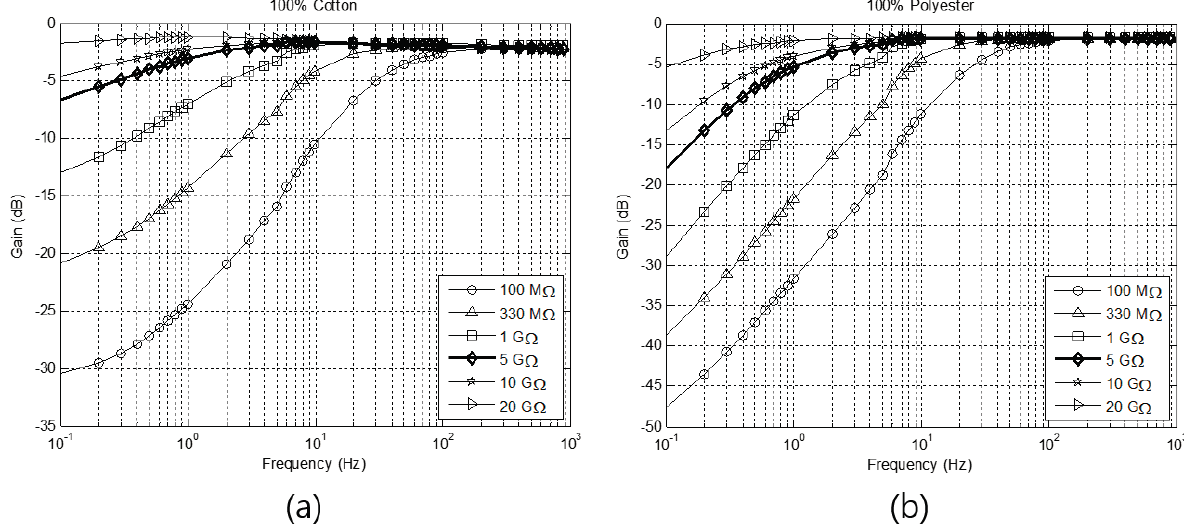
Figure 4. Frequency responses for different resistances: ( a ) Using 100% cotton as insulator; ( b ) using 100% polyester as